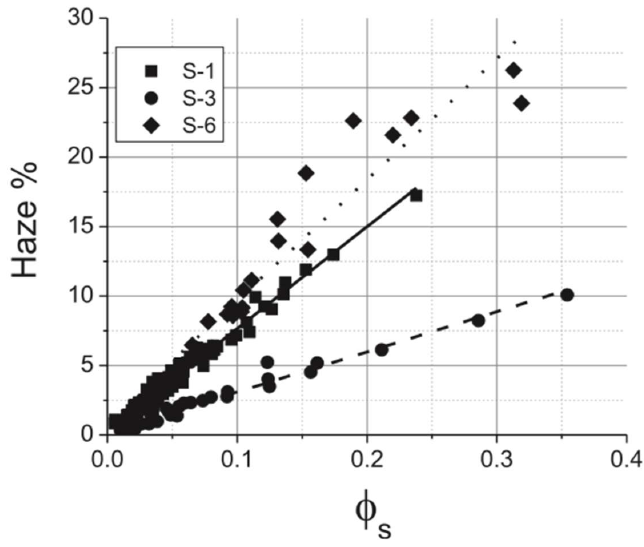
Figure 2. Scattering geometry of nanowires in films. Reprinted from [19], with the permission from AIP Publishing, 2013.